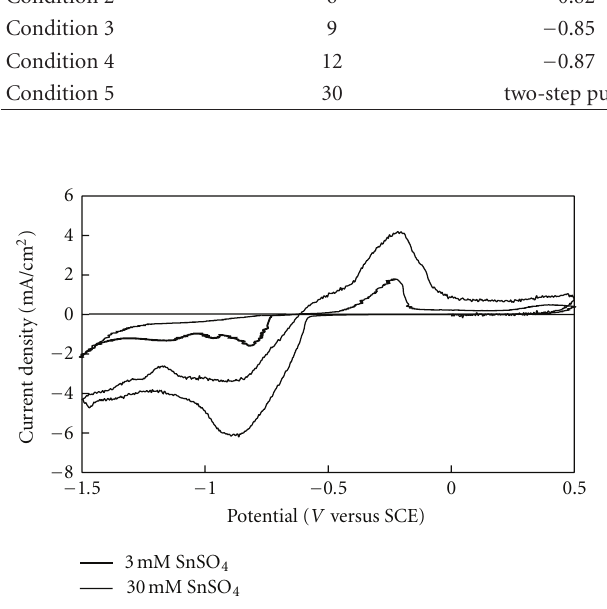
Figure 2: Cyclic voltametry results for the solutions containing 3mM and 30 mM SnSO 4 .